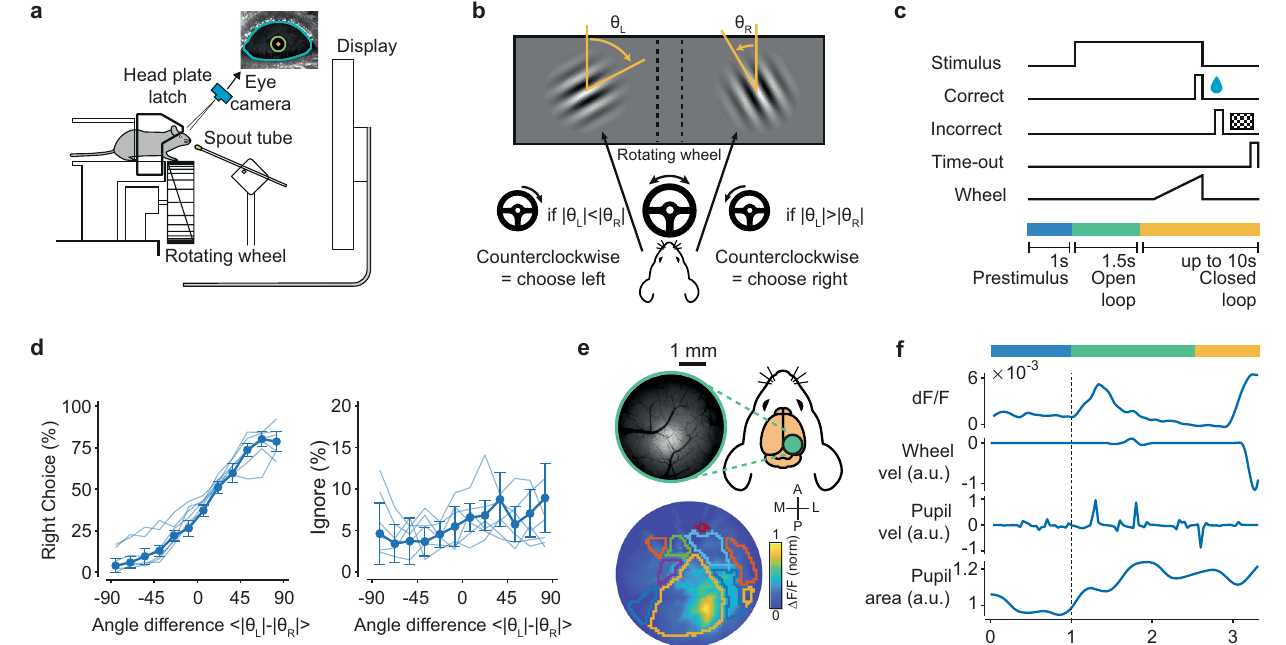
Fig.1|Imagingtheposteriorcortexduringanorientationdiscriminationtask. a Mice weretrained ona2AFCorientationdiscriminationtaskusing anautomated setup featuring voluntary head fi xation. They signaled a L/R choice by rotating a toy wheel with their front paws. Schematic adapted from 37 . b Mice rotated the wheel to position the most vertical of two oriented gratings in the center of the screen. c Trial structure: After a 1s pre-stimulus period, the stimulus was pre- sented,followedbya1.5sopen-loop(OL)intervalinwhichwheelmovementswere decoupled from stimulus movements. Thereafter, in the closed-loop (CL) period, wheel rotations resulted in L/R horizontal shifts of the stimuli. Correct choices were rewarded with water; incorrect choices were followed by a checkerboard pattern presentation. Ten seconds of no movement in the CL period triggered a time-outperiod. d Left:mice ’ sperformanceinthetask(fractionofrightchoices)as